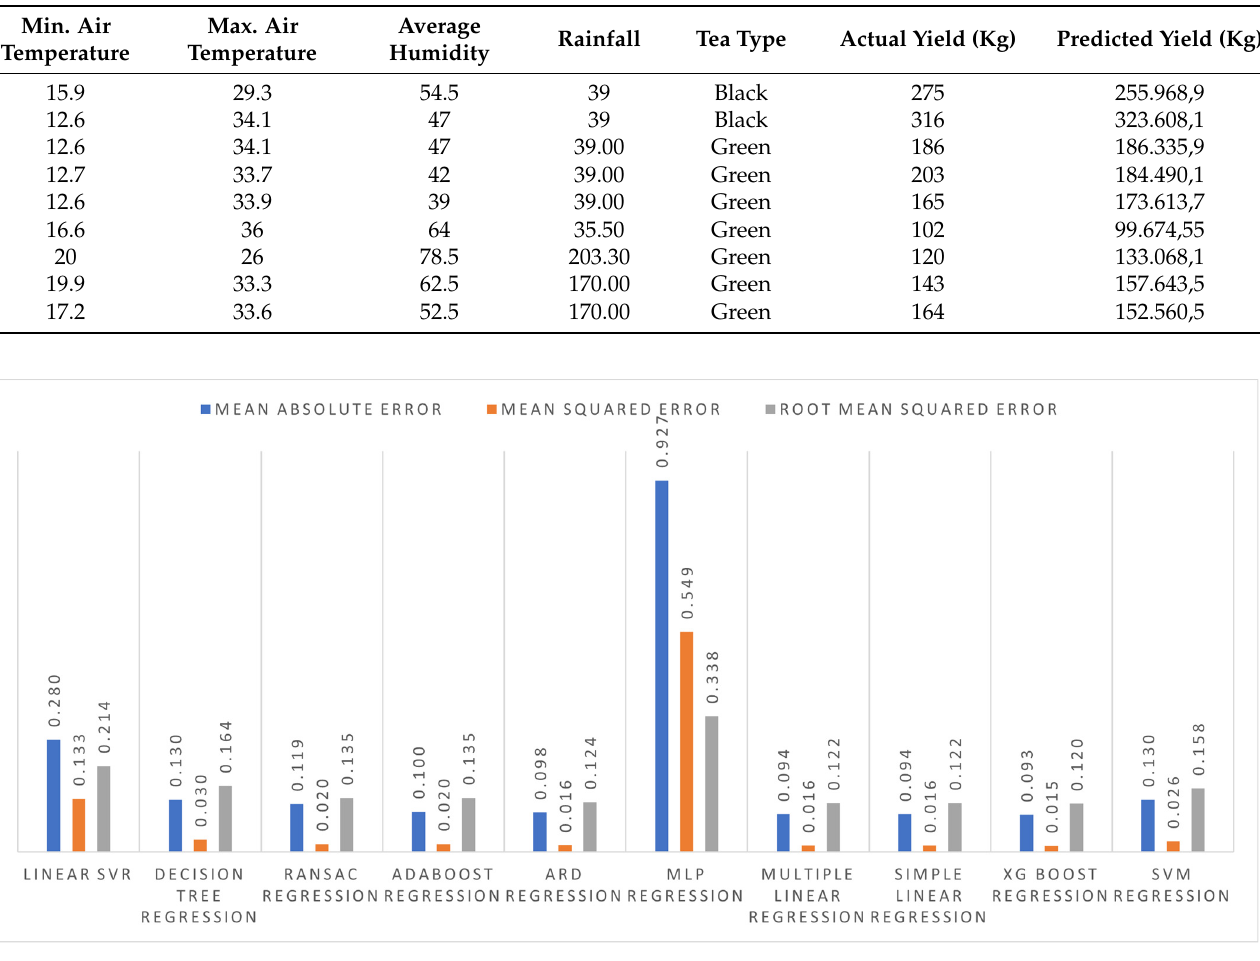
Table 5. An overview of the test data.